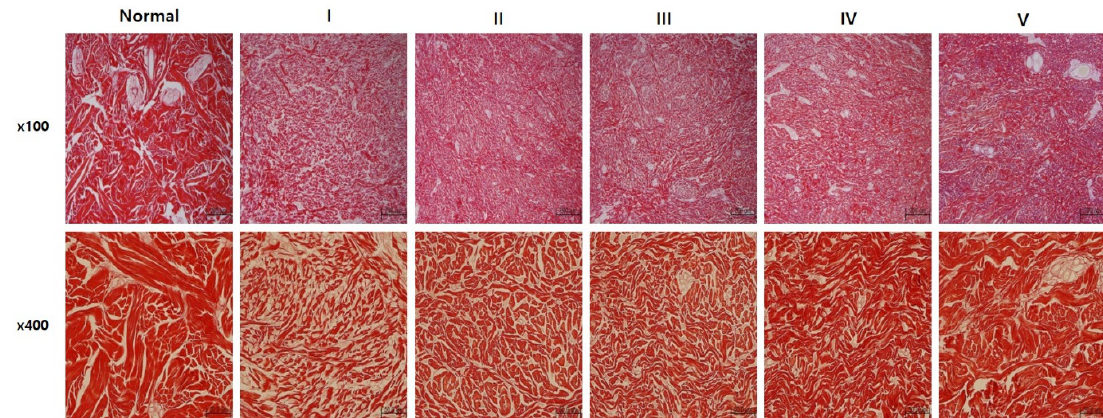
Figure 3. sLRP6E1E2-expressing Ad/gel induces collagen rearrangement. Picrosirius red staining in pig scar tissues. On the 50th day after treatment, premature collagen depositions were displaced by mature and well-arranged collagen bundles, and scar tissues in Groups IV and V had closely packed collagen fibers and formed complete bundles compared to other groups (Groups I to III), which is similar to normal dermal structure. Magnification × 100 (upper), × 400 (lower).